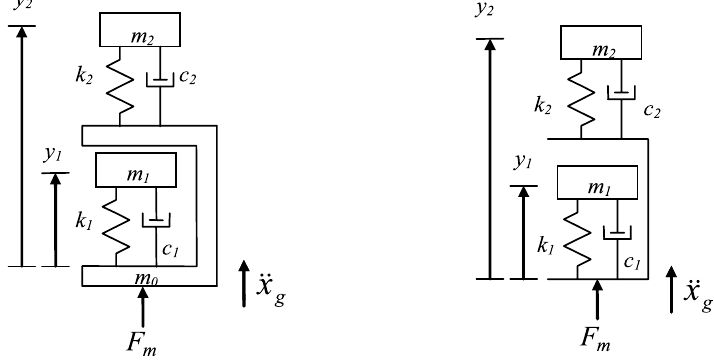
Fig. 1. Lumped parameter model for a seated human (left) and a standing human (right), reproduced from